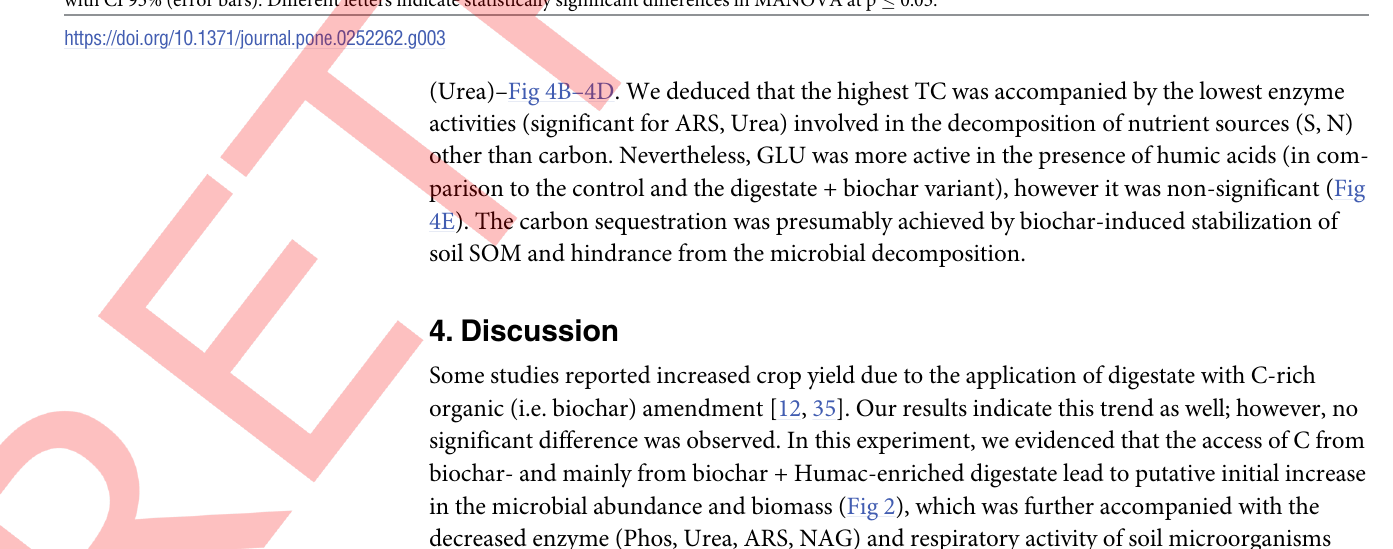
Fig 3. e-g Basal (a) and substrate-induced respiration: D-glucose (b), D-trehalose (c) , N-acetyl- β -D-glucosamine (d), L-alanine (e), L-lysine (f), L-arginine (g) –M with CI 95% (error bars). Different letters indicate statistically significant differences in MANOVA at p �